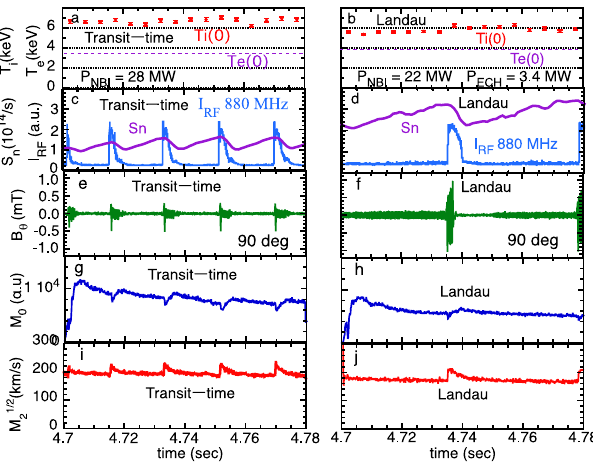
Fig. 1 Plasma discharges with transit-time damping and Landau